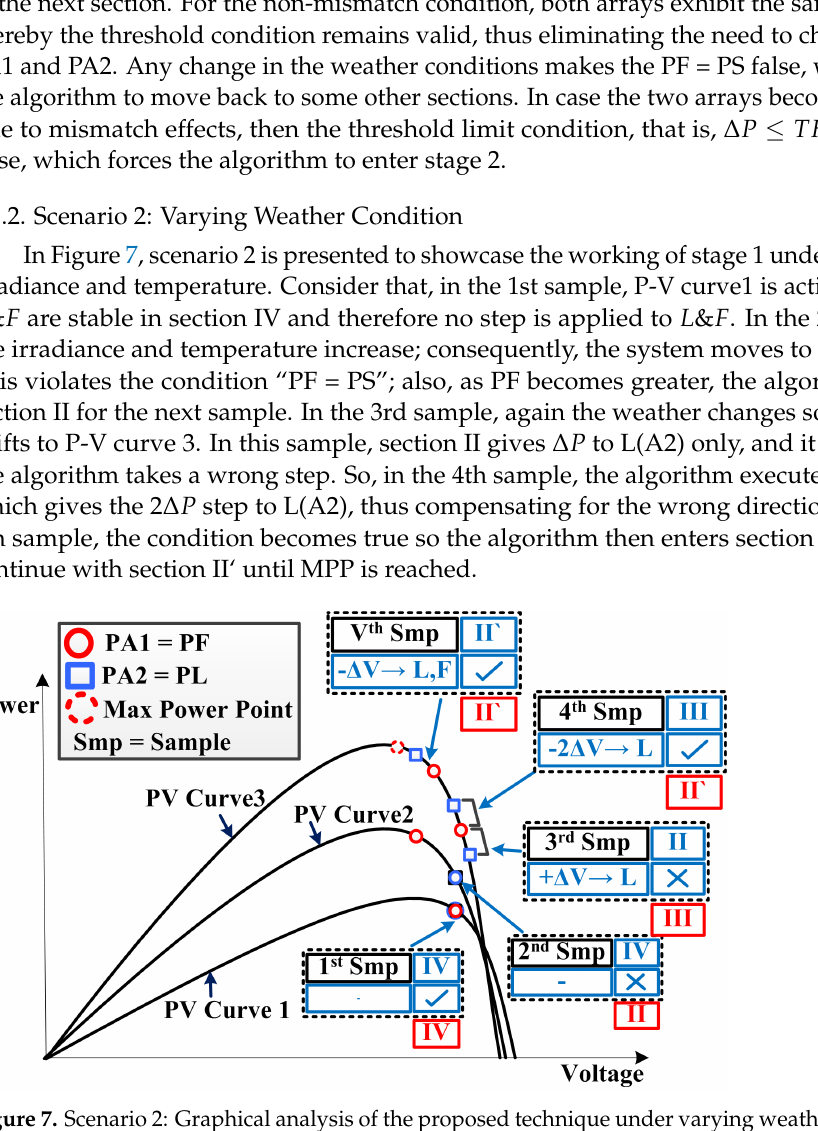
Figure 7. Scenario 2: Graphical analysis of the proposed technique under varying weather